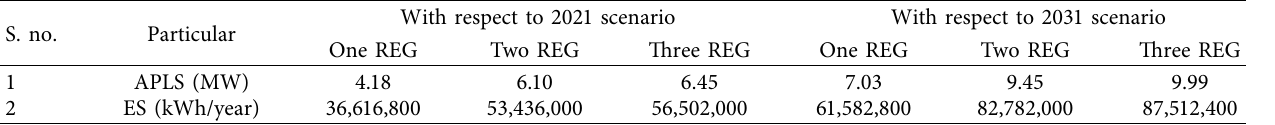
Table 11: Active power loss